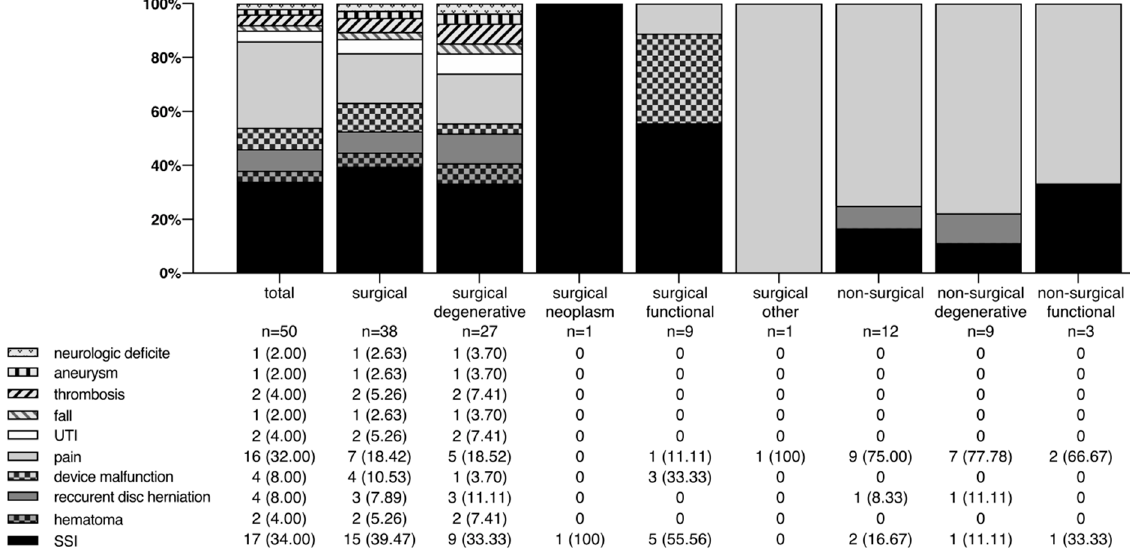
Figure 1. Reasons for unplanned readmission according to the index diagnosis groups. n , number; SSI, surgical site infection; UTI, urinary tract infection.